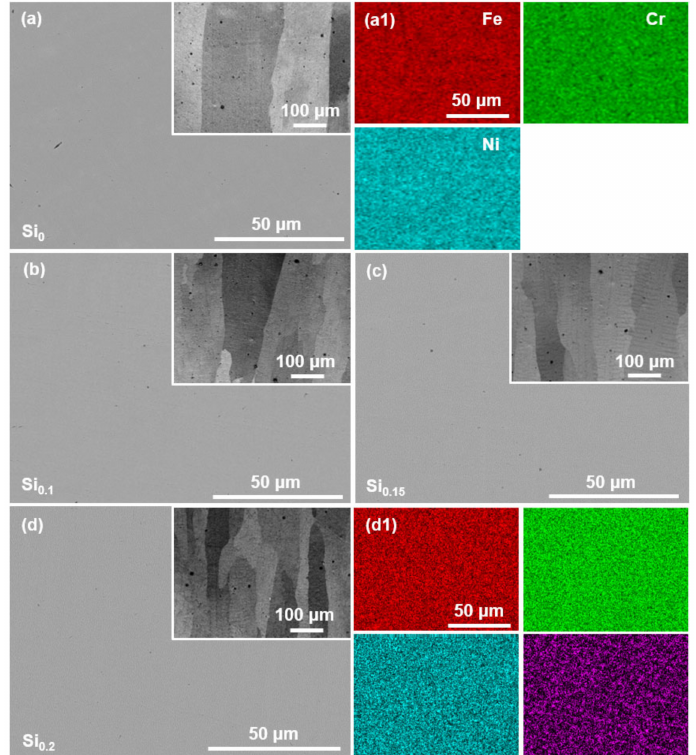
Figure 2. SEM images of the as-cast ( a ) Si 0 , ( b ) Si 0.1 , ( c ) Si 0.15 , and ( d ) Si 0.2 MEAs, respectively. ( a1 ) and ( d1 ) show the corresponding element mapping of ( a ) and ( d ),